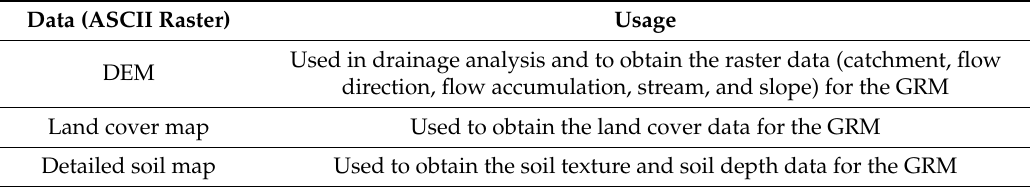
Table 2. Geographical and hydrological input data for the GRM. Data (ASCII Raster) Usage Used in drainage analysis and to obtain the raster data (catchment, flow DEM direction, flow accumulation, stream, and slope) for the GRM Land cover map Used to obtain the land cover data for the GRM Detailed soil map